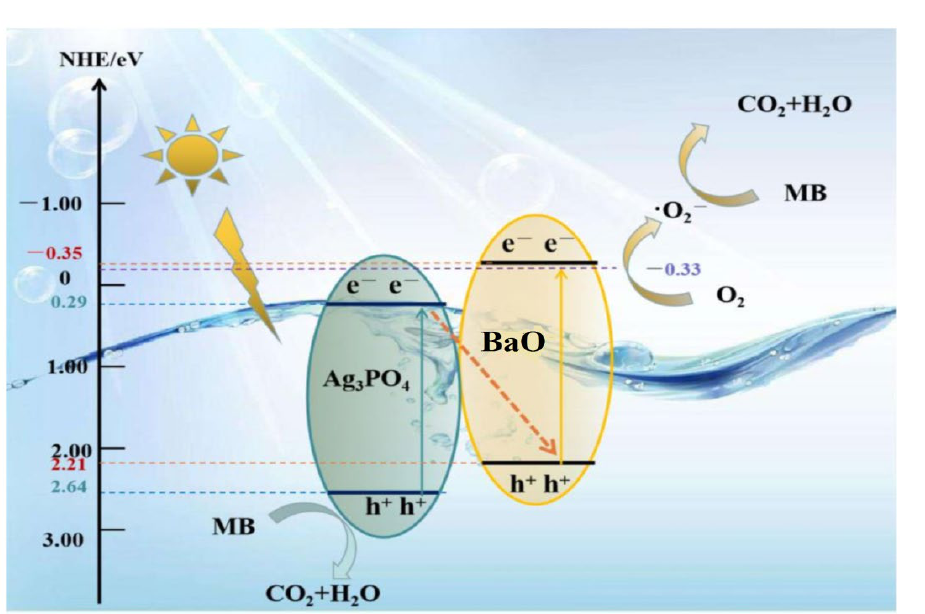
Figure 7. Schematic diagram of the photocatalytic mechanism of BaO@Ag 3 PO 4 nanocomposite under visible light irradiation.